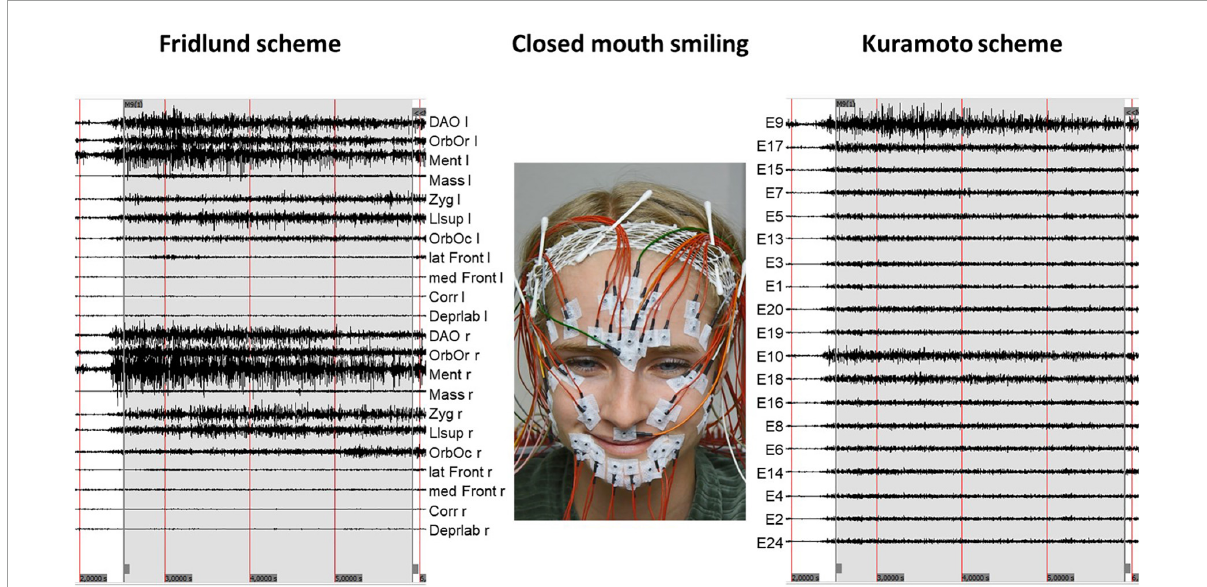
FIGURE2 Example of an sEMG recording during a specific task (here closed mouth smiling). The recordings of Fridlund electrodes are shown on the (left side) . The recording related to the Kuramoto electrodes is shown on the (right side) . The numbering of the electrodes of the Kuramoto scheme is following the original numbering of Kuramoto et al. (2019). The positioning of the electrodes is following the muscle anatomy. l, left side; r, right side; DAO, depressor anguli oris muscle; OrbOr, orbicularis oris muscle; Ment, mentalis muscle; Mass, masseter muscle; Zyg, zygomatic muscle; Llsup, levator labii superioris muscle; OrbOc, orbicularis oculi muscle; lat Front, lateral part of the frontalis muscle; med Front, medial part of the frontalis muscle; Corr, corrugator supercilii muscle; Deprlab, depressor labii